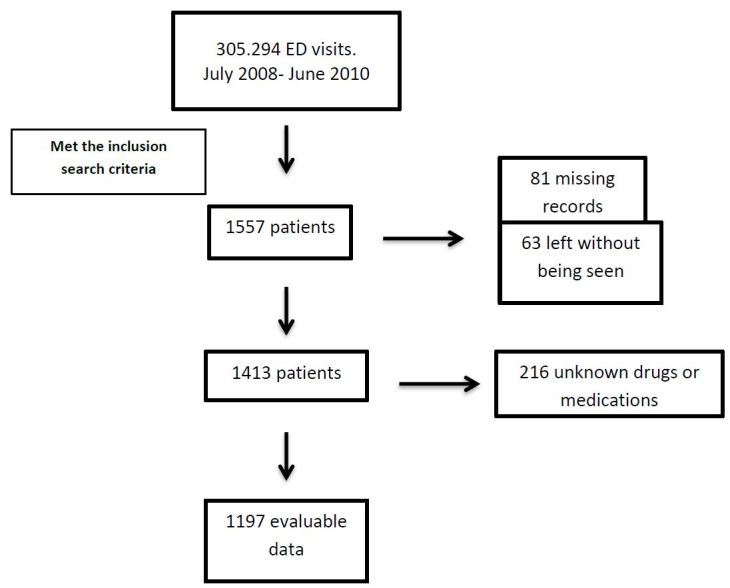
Flow diagram of the study chart review.ED, emergency department